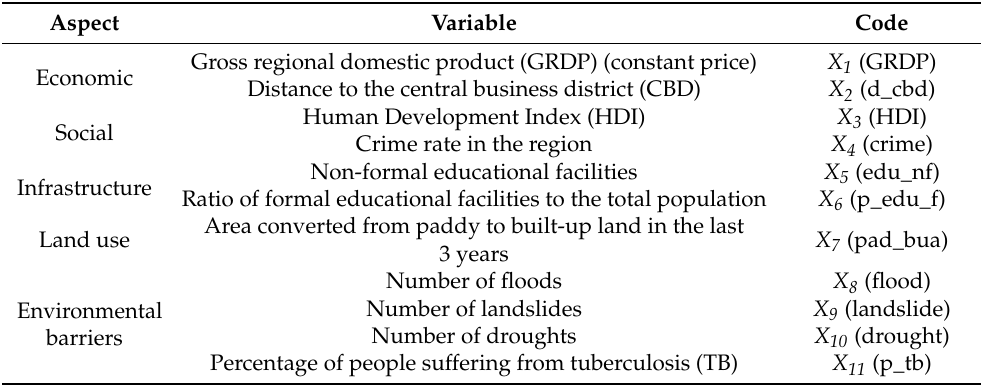
Table 1. Independent variables ( X ) included in the OLS and GWR